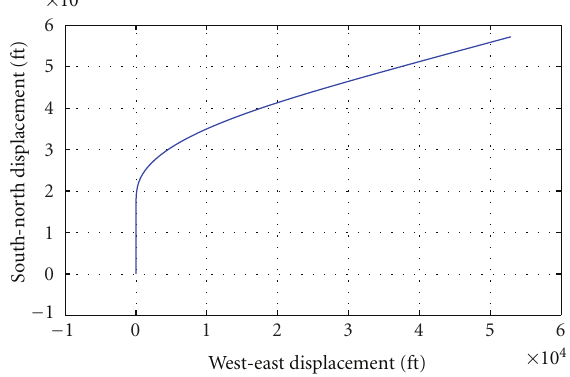
Figure 11: Ground track of the aircraft.